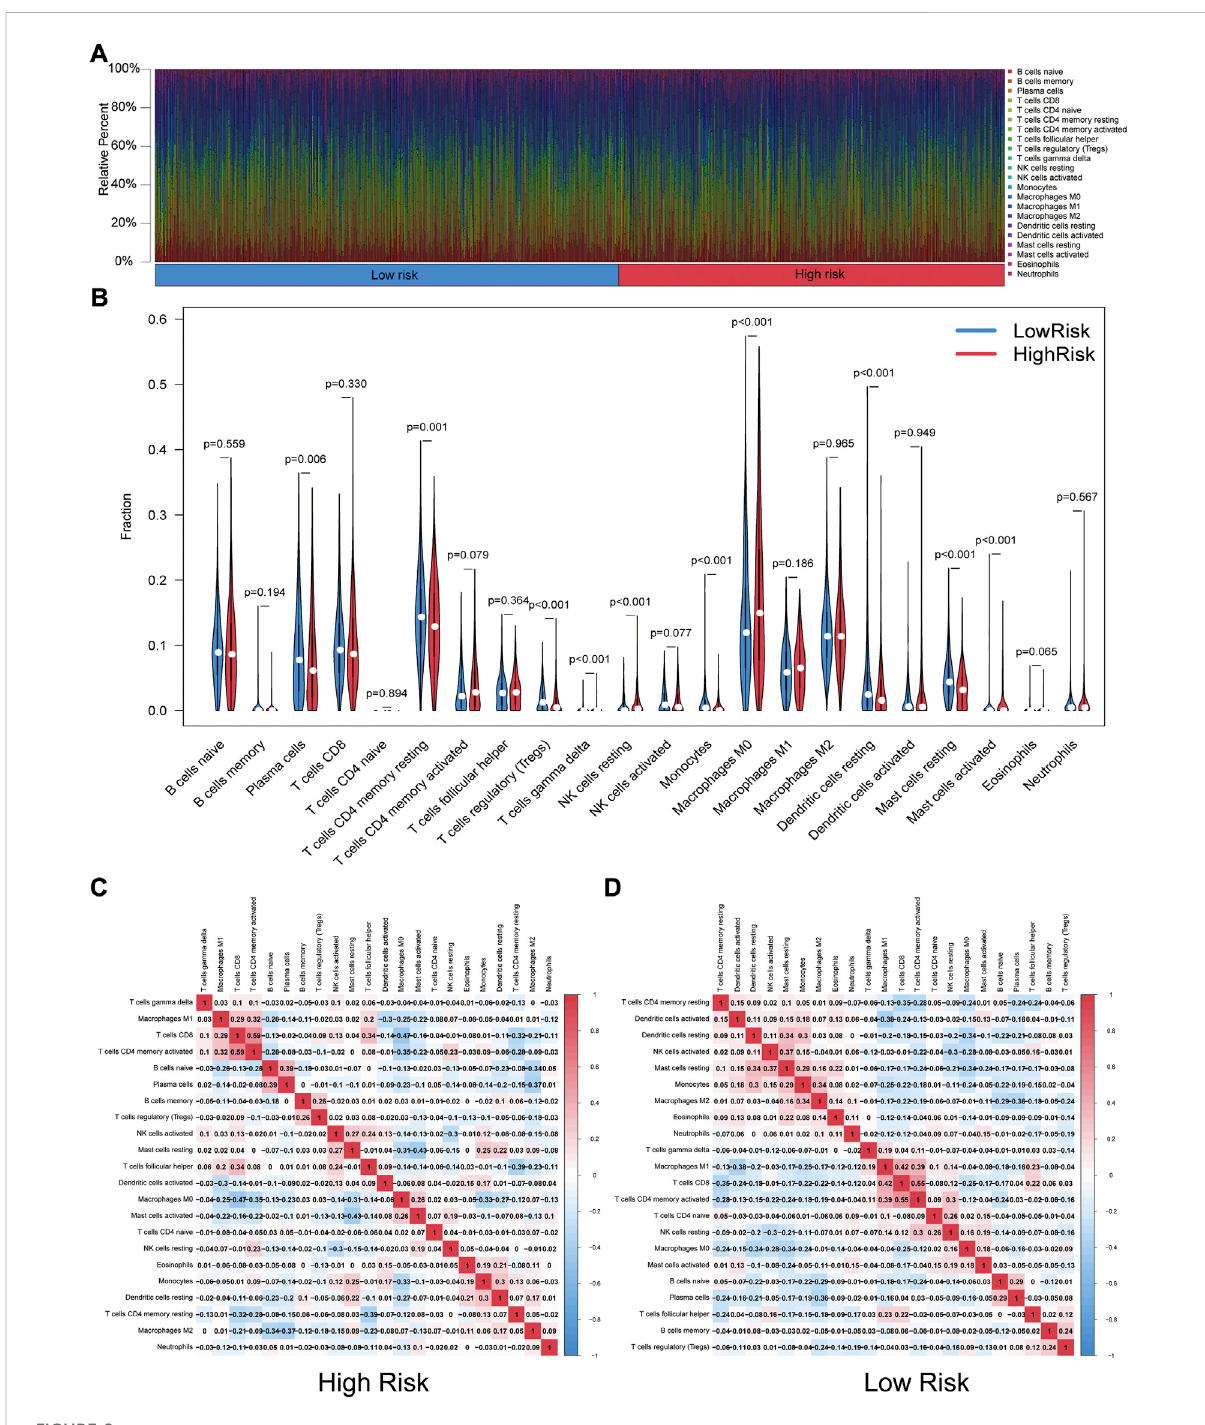
FIGURE 8 Landscape of tumor-in fi ltrating immune cells. (A) Immune status in the two risk groups. (B) Different levels of in fi ltration of 22 immune cells in the high- and low-risk groups. (C) (D) Correlation between immune cells in high- and low-risk groups (red squares represent positively correlated, blue squares represent negatively